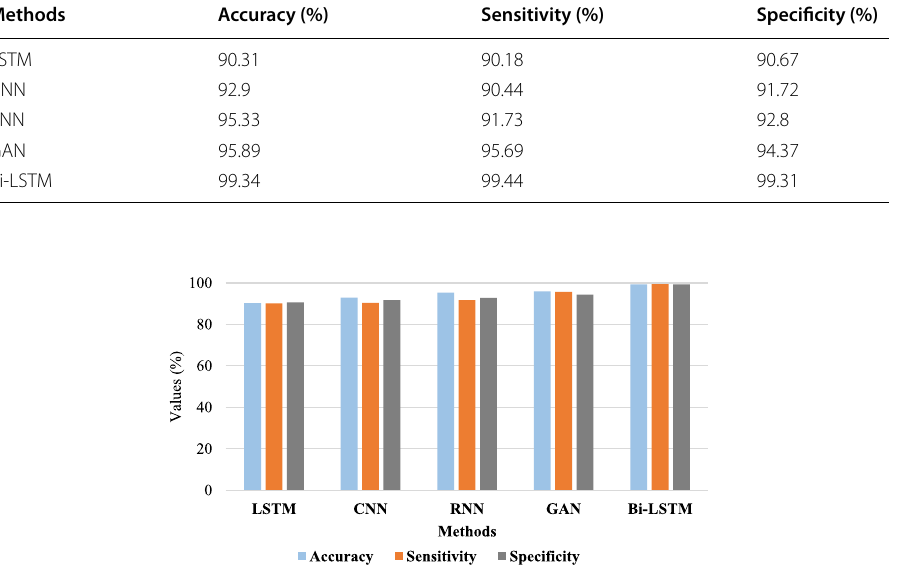
Fig. 11 Comparison of deep learning methods on UCM